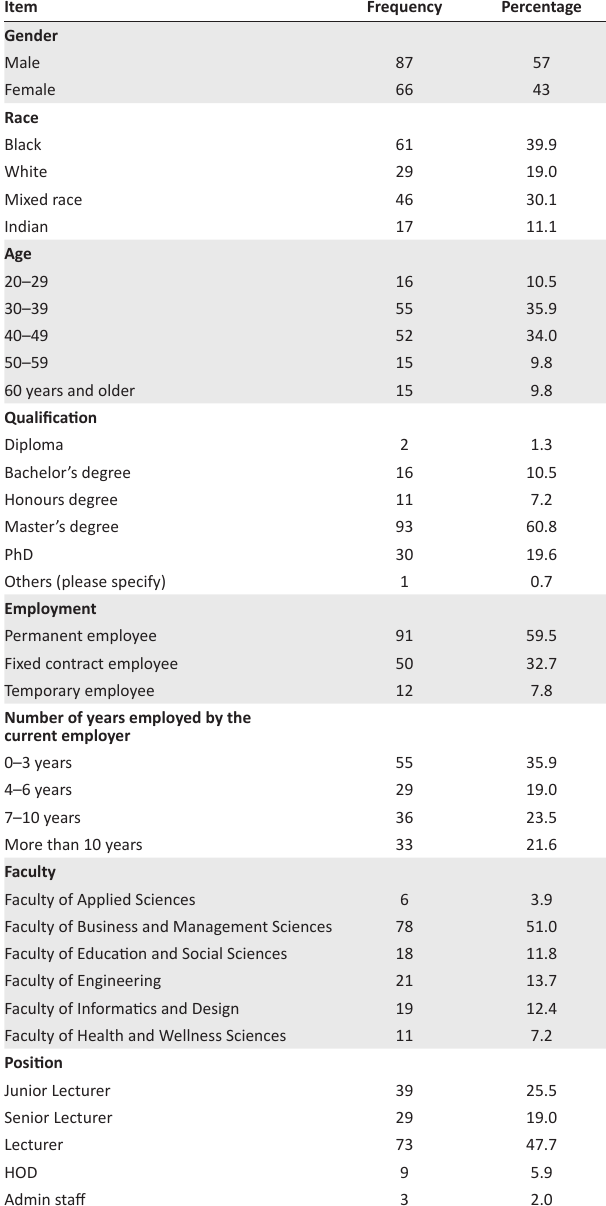
TABLE 2: Demographic information of quantitative data.